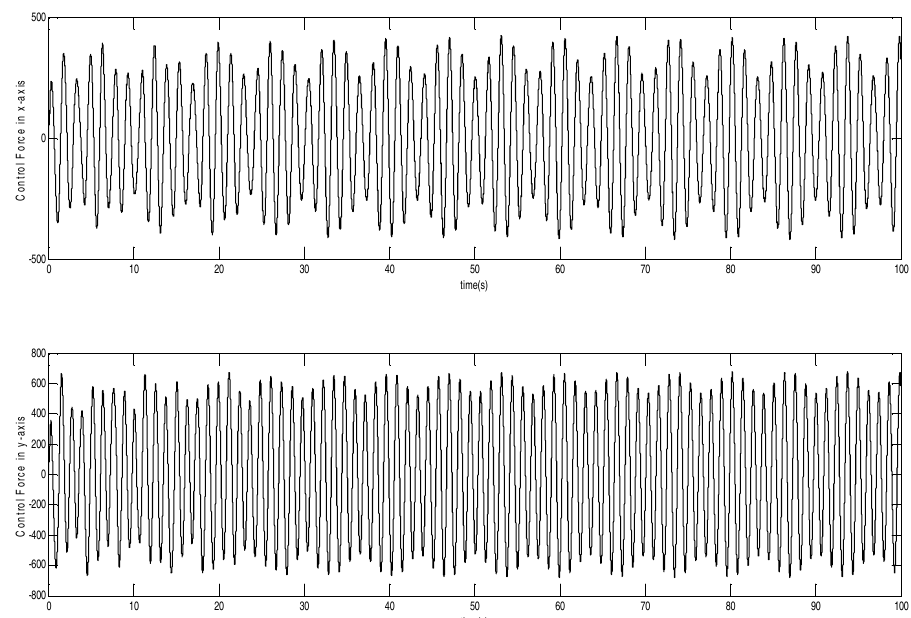
Figure 5. Control input using adaptive dynamic sliding mode control based on the backstepping approach.